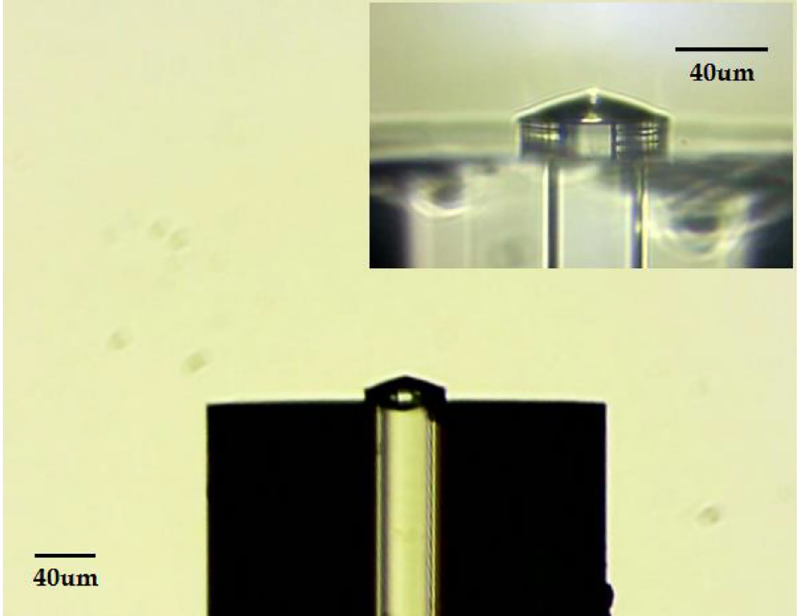
Figure 7: Digital microscope images at 220 × magni fi cation of the fabricated axicons on the endface of the optical fi